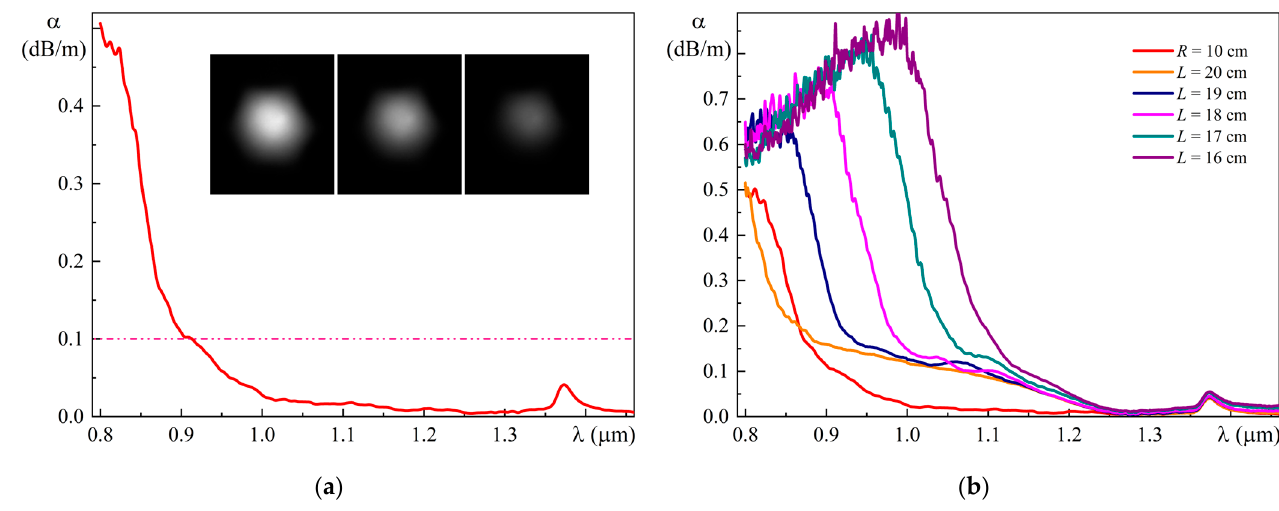
Figure 15. ( a ) Measured losses of the fabricated MOF-18 at a bending radius of R = 0.1 m. Inset– observed intensity in the near- fi eld of MOF-18 at di ff erent displacements of the incoming beam; ( b ) Dependences of losses of the fabricated MOF-18 from bending when varying the distance L between the two walls, limiting the free coil with MOF-18.